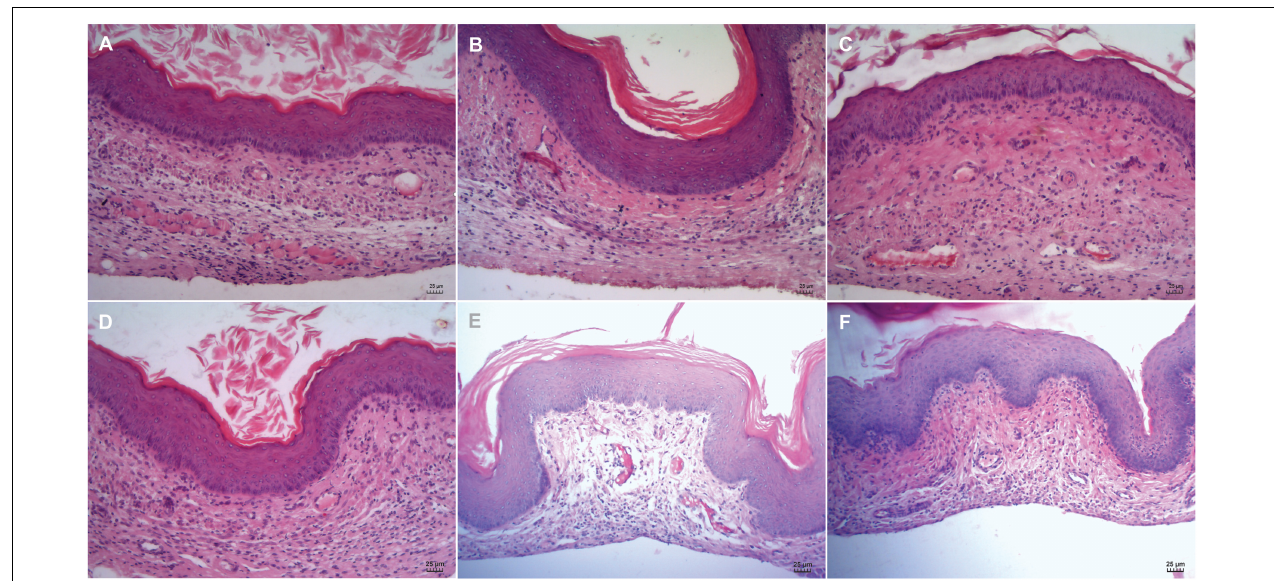
FIGURE 7 | Biocompatibility of carbomer-based hydrogels. Histological analysis of cervicovaginal mucosa of BALB/c mice treated with PBS (A,D) , CARB-BF (B,E) , and CARB-CO 1.0 (C,F) after 24 h (A–C) and 14 days (D–F) . All images showed epithelial integrity and intact lamina propria. Bar: 25 µ